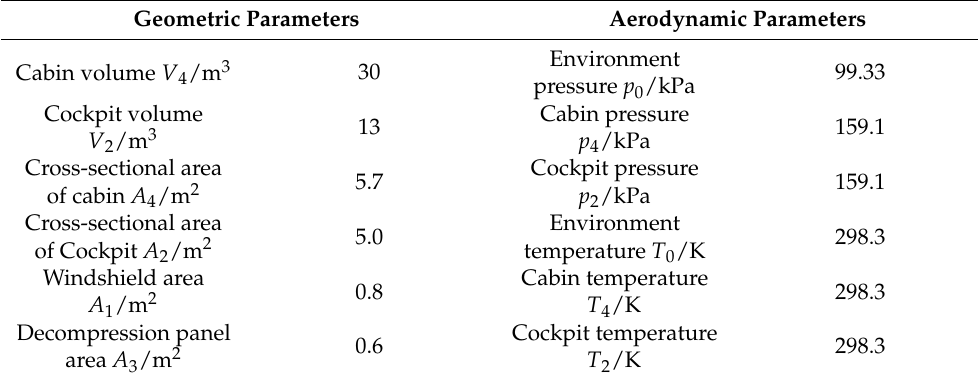
Table 2. Experimental parameters.